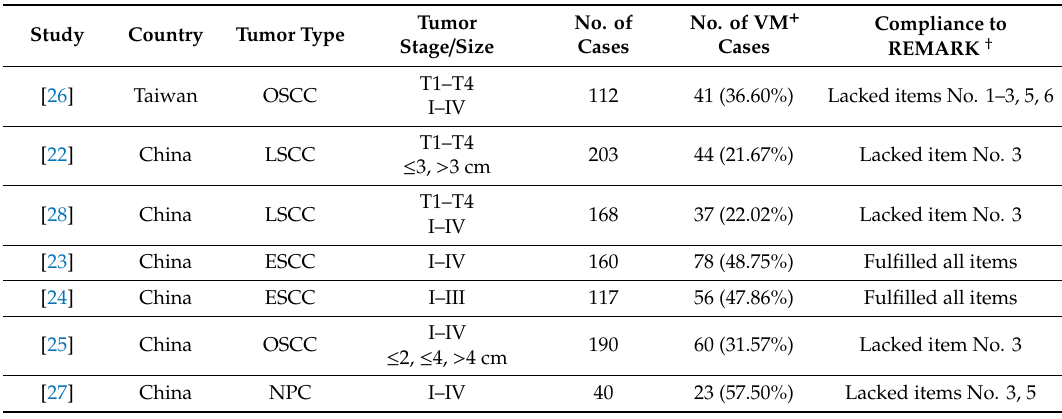
Table 2. Characteristics of the included